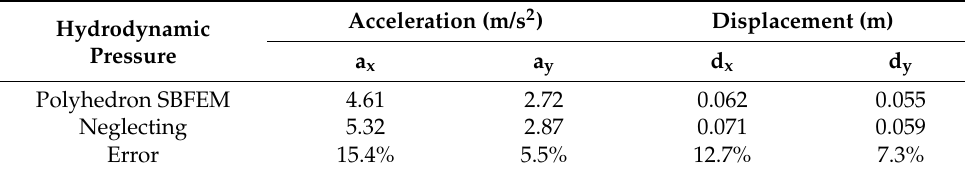
Table 3. Maximum dynamic response of a rockfill under an